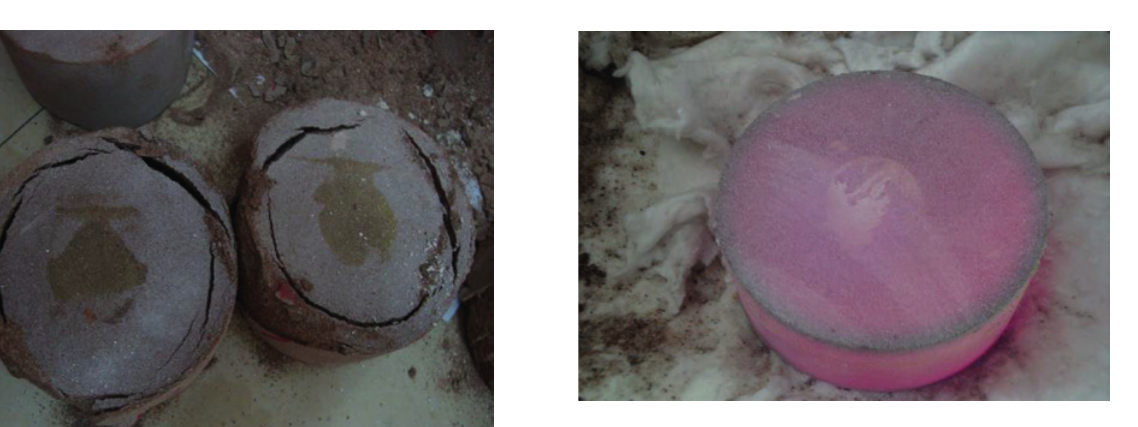
Fig. 4: The exterior shape of sandstone that stays six hours indoors after high temperatures